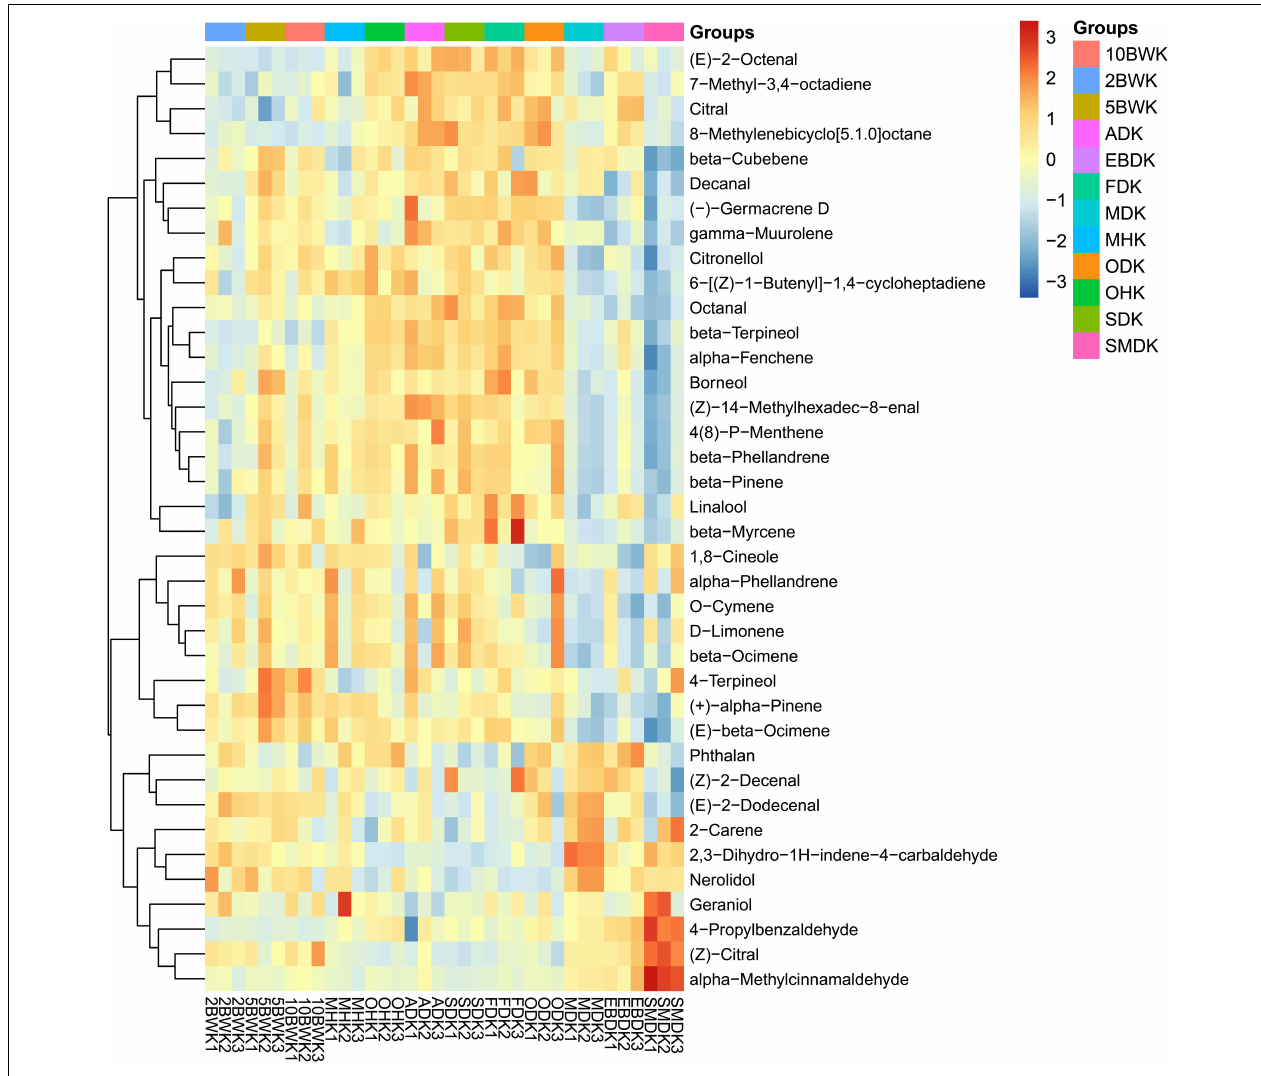
FIGURE 2 | Heat map visualization of volatiles in the kernel of A. tsao-ko with different pre-drying and drying